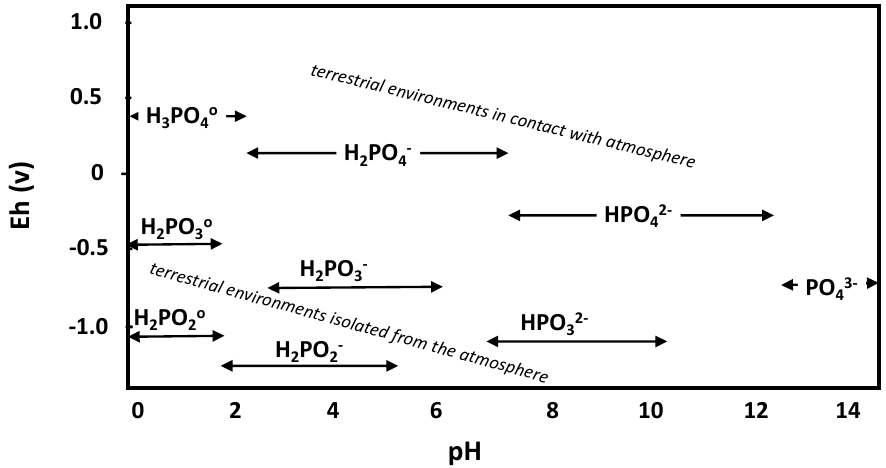
Figure 4. Influence of pH and oxidation (Eh) on Phi and Pi species in solution. Area in white represents current atmospheric conditions, red represents reduced conditions, and blue is highly oxidized (not common under normal atmospheric